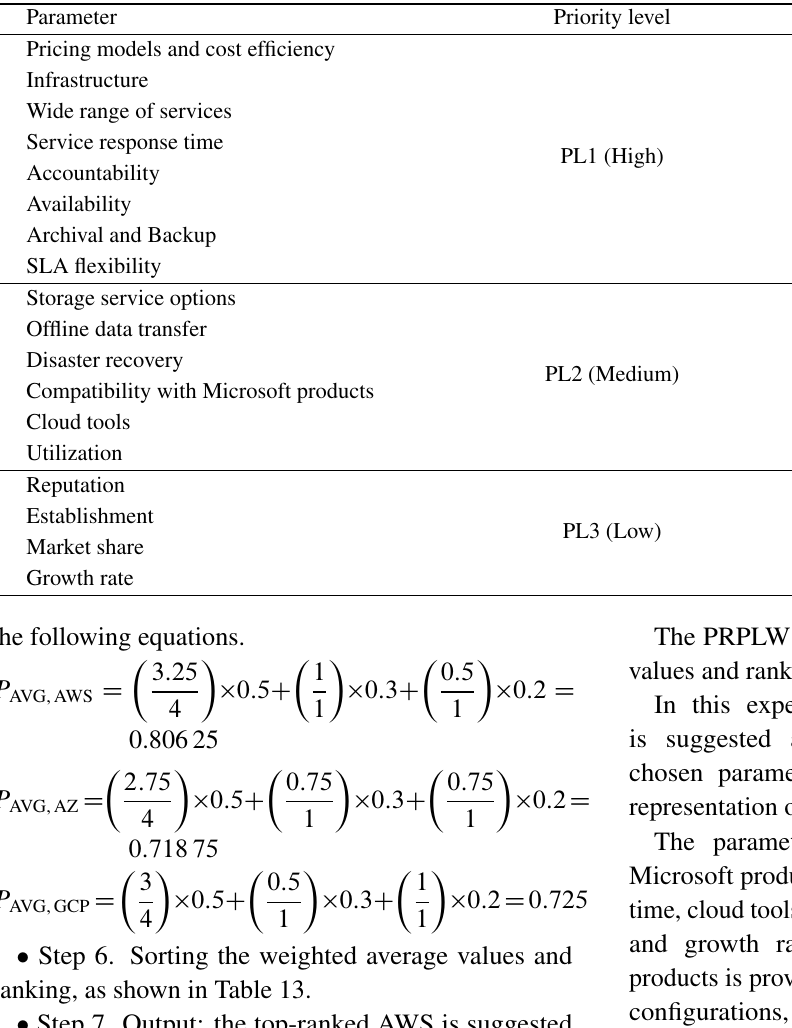
Table 12 Priority level categories and